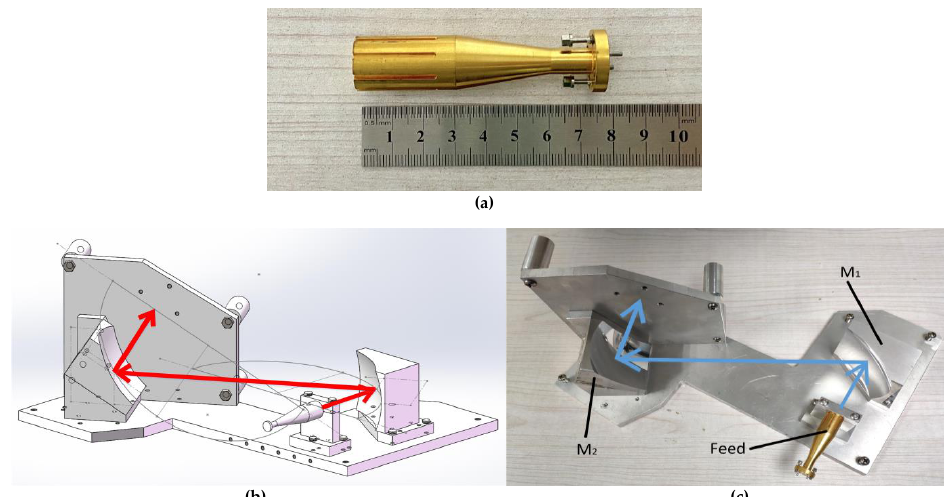
r : ( a ) E-plane; ( b ) H-plane.